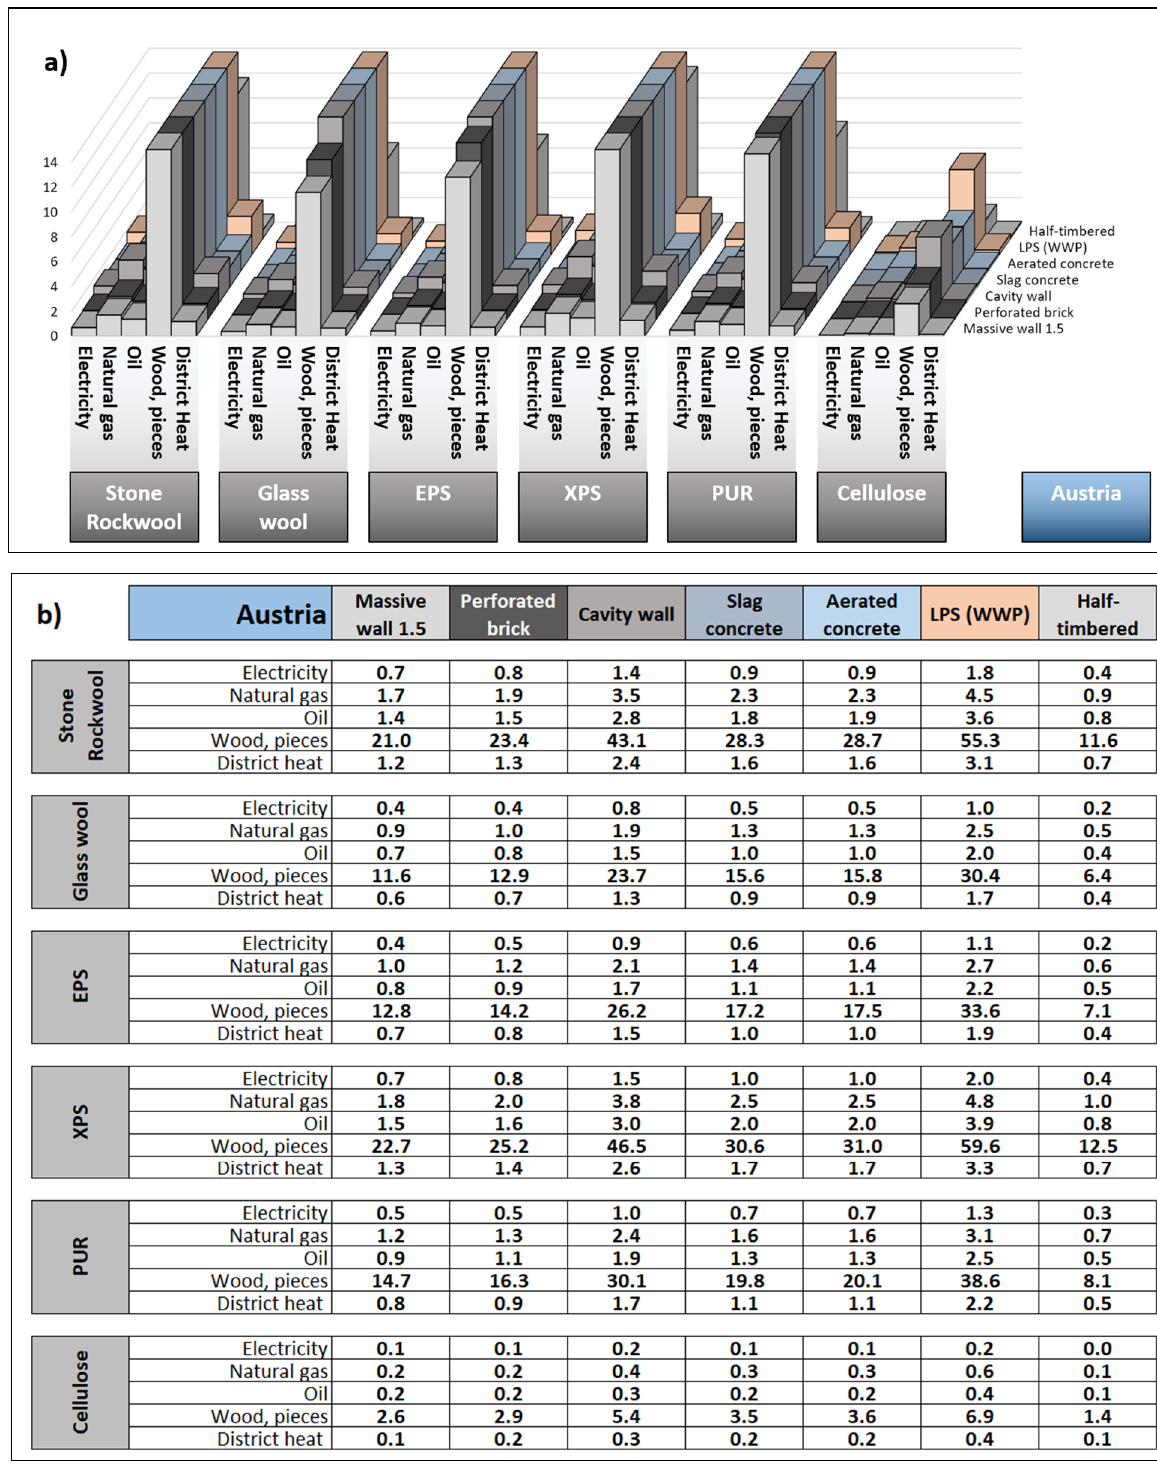
Figure 8. ( a ) CPP values chart for Austria. ( b ) CPP values for Austria. After averaging the data available from the EPDs available for Austria, the PEFn val- ues, the emission factors and the climatic conditions for Vienna, the highest CPP values were found for existing walls with the greatest resistance, for spaces heated with biomass and for XPS insulation (up to 59.6 years), stone/rockwool (up to 55.3 years) and PUR (up to 38.6 years). Such high CPP values for biomass heating result from the very low PEFn value in Austria [59]. The lowest CPP values are observed in existing walls with the least resistance, for spaces heated with electricity and for Cellulose (0.1 year), glass wool and EPS (0.4 year). Depending on the energy source, the average CPP ranges from 0.7 for elec- tricity to 20.4 for biomass, and depending on the type of insulation, it ranges from 0.9 for cellulose to 8.0 for XPS, something which is shown in Table 11a (CPP for various energy sources, regardless of the insulation method) and Table 11b (CPP for different insulation materials, regardless of the method of heating). The higher CPP values for various insu- lation materials are due to the higher embodied carbon (C E ) values resulting from the EPD declaration for materials available in Austria. Table 11. ( a ): Average CPP values for different energy sources. ( b ): Average CPP values for various insulation materials.